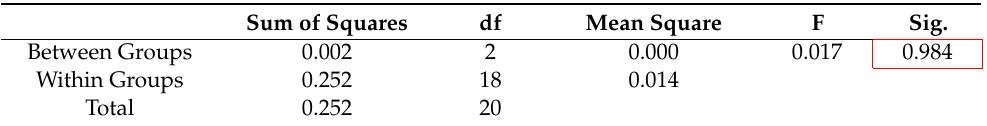
Table 9. Results of one-way ANOVA with the k value as 3, 5, and 7 (prediction success rate of pinch gesture for each subject). Sum of Squares df Mean Square F Sig. Between Groups 0.002 2 0.000 0.017 0.984 Within Groups 0.252 18 0.014 Total 0.252 20